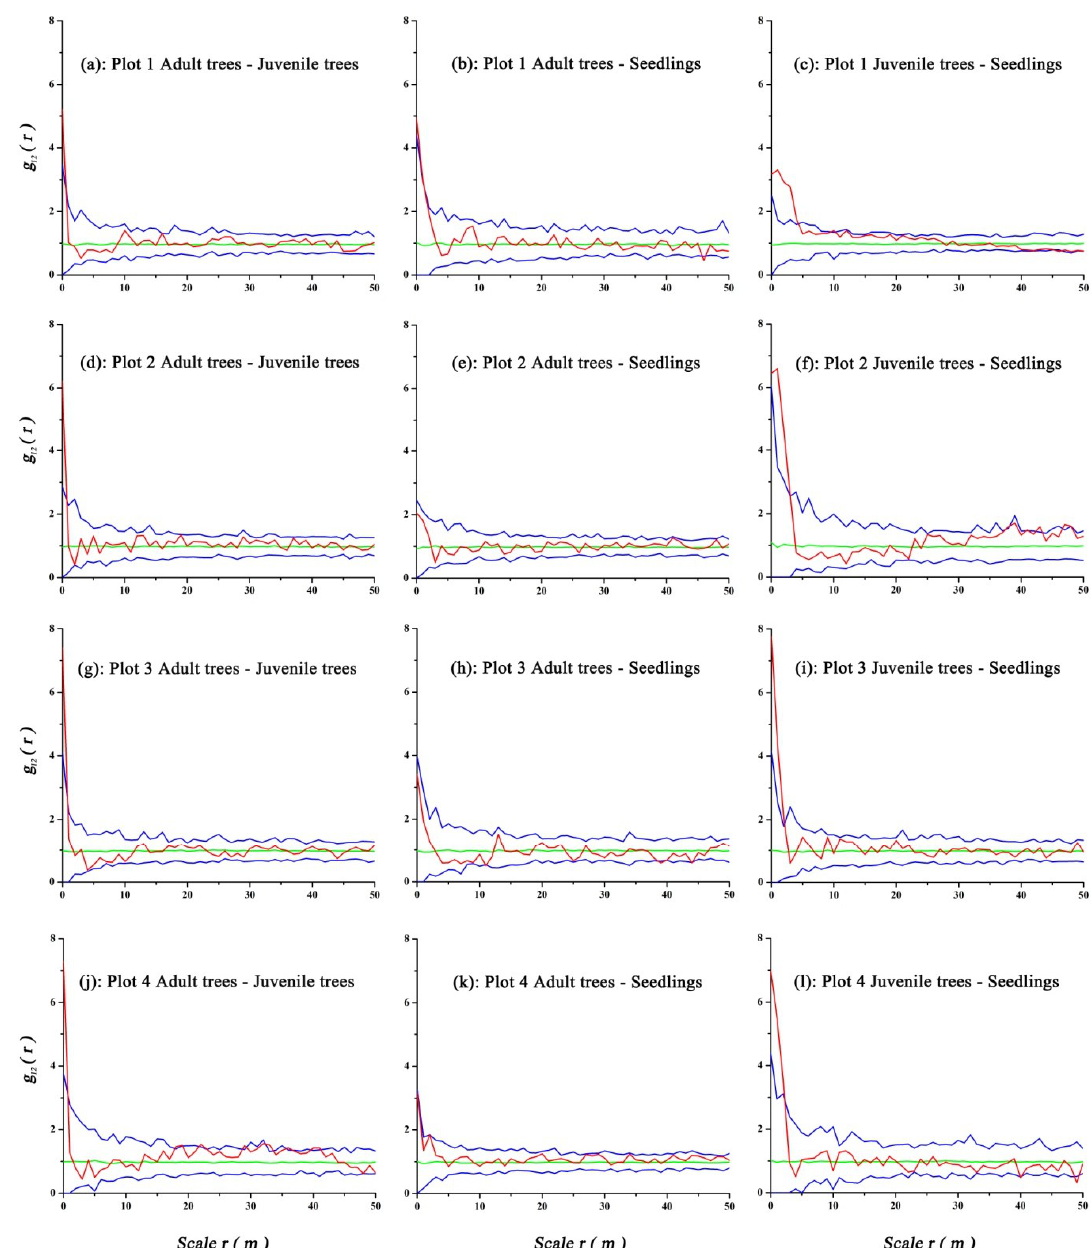
Figure 5. Spatial associations of different life stages of U. pumila with the CSR null model. Graph colors are defined in Figure 4.